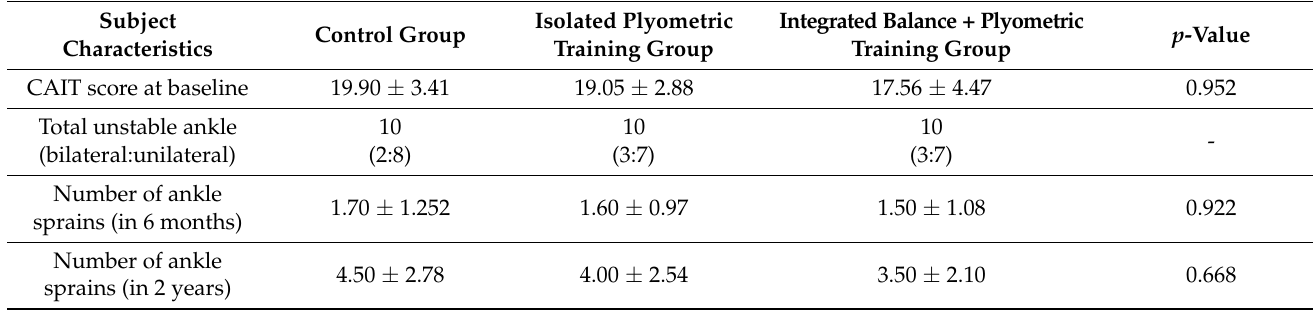
Table 1. Subject characteristics and history of ankle sprain in each group (mean ±